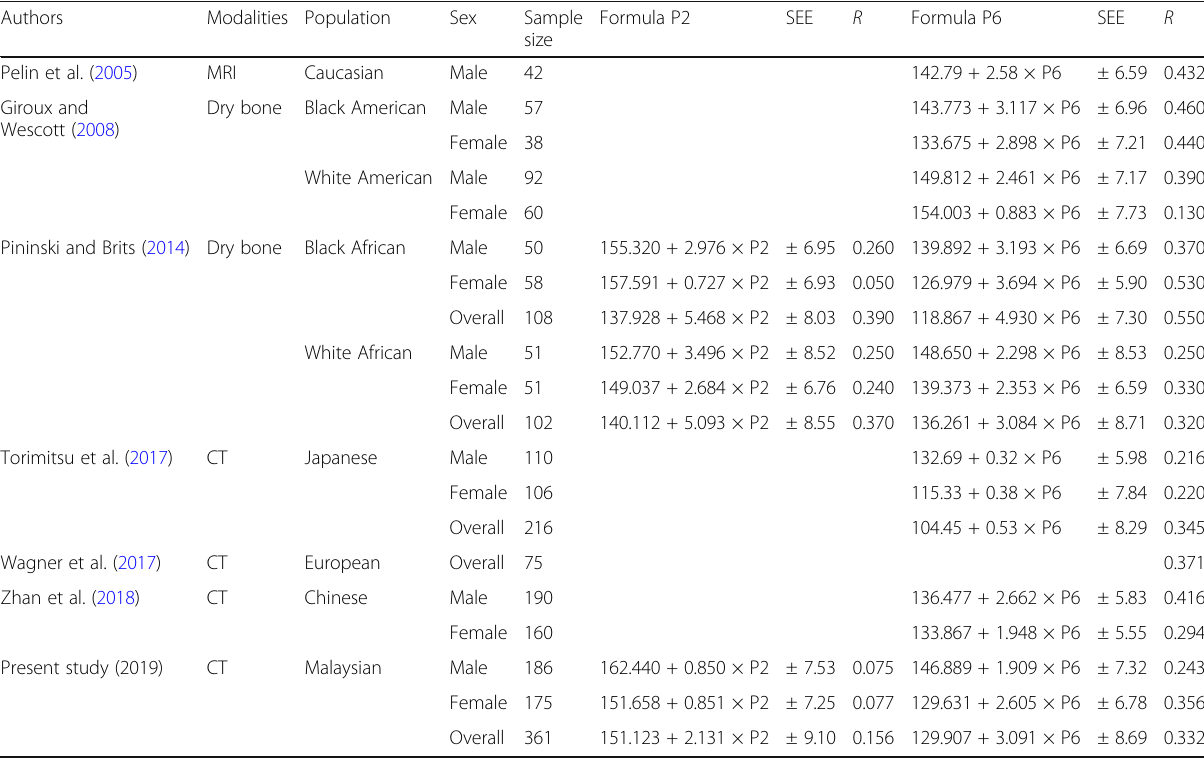
Table 9 Comparison of regression analysis reported by the previous studies and the present study for stature